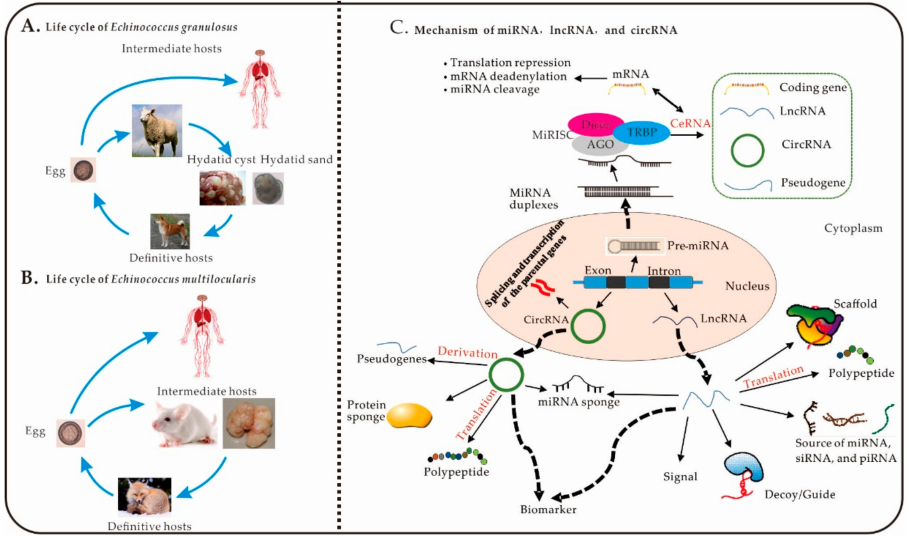
Figure 1. The life cycle of Echinococcus spp. and mechanisms of miRNAs, lncRNAs, and circRNAs. ( A ), Life cycle of E. granulosus . ( B ), Life cycle of E. multilocularis. ( C ) Mechanisms of miRNAs, lncRNAs, and circRNAs: (1) MiRNA : pre-miRNA is transcribed from genomic DNA with a double-stranded RNA hairpin and a stem-loop structure in the nucleus [38,39]. The mature miRNA can be loaded into the RNA-induced silencing complex (RISC), resulting of miRNA, Dicer, the RNA-binding protein Argonaute (AGO), and the adaptor protein TAR-RNA-binding protein (TRBP) [40]. The complementary sequences in the untranslated regions of lncRNAs, mRNAs, circRNAs, and pseudogenes can competitively bind to miRNAs, which results in translational repression and degradation of mRNA and miRNA cleavage. (2) CircRNA : circRNAs are spliced and transcribed from genomic DNA and transported to the cytoplasm to perform numerous biological functions. One example of such functions is the translation of derived pseudogenes, sponge proteins and miRNAs, into polypeptides [41]. (3) LncRNA : lncRNAs play important biological roles in the cytoplasm; including acting as signalling molecules, decoys, guides, and sca ff olds; being translated into polypeptides, and serving as sources of small interfering RNAs (siRNAs), miRNAs, and Piwi-interacting RNAs (piRNAs) [42]. 2. Widespread Expression of miRNAs in Echinococcus spp. According to Transcriptome